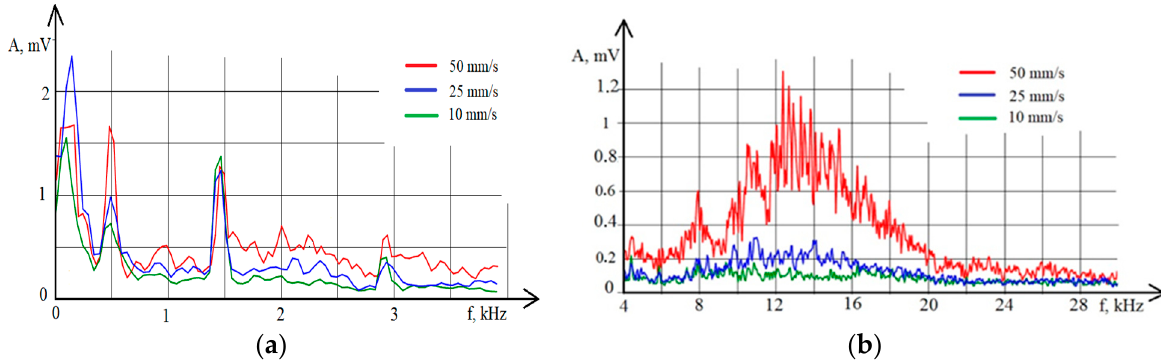
Figure 9. Spectra of the VA signal in the low ( a ) and high ( b ) frequency ranges when sintering an AISI 410 steel powder layer with different laser beam speeds: (1)—10 mm/s; (2)—25 mm/s; (3)—50 mm/s.